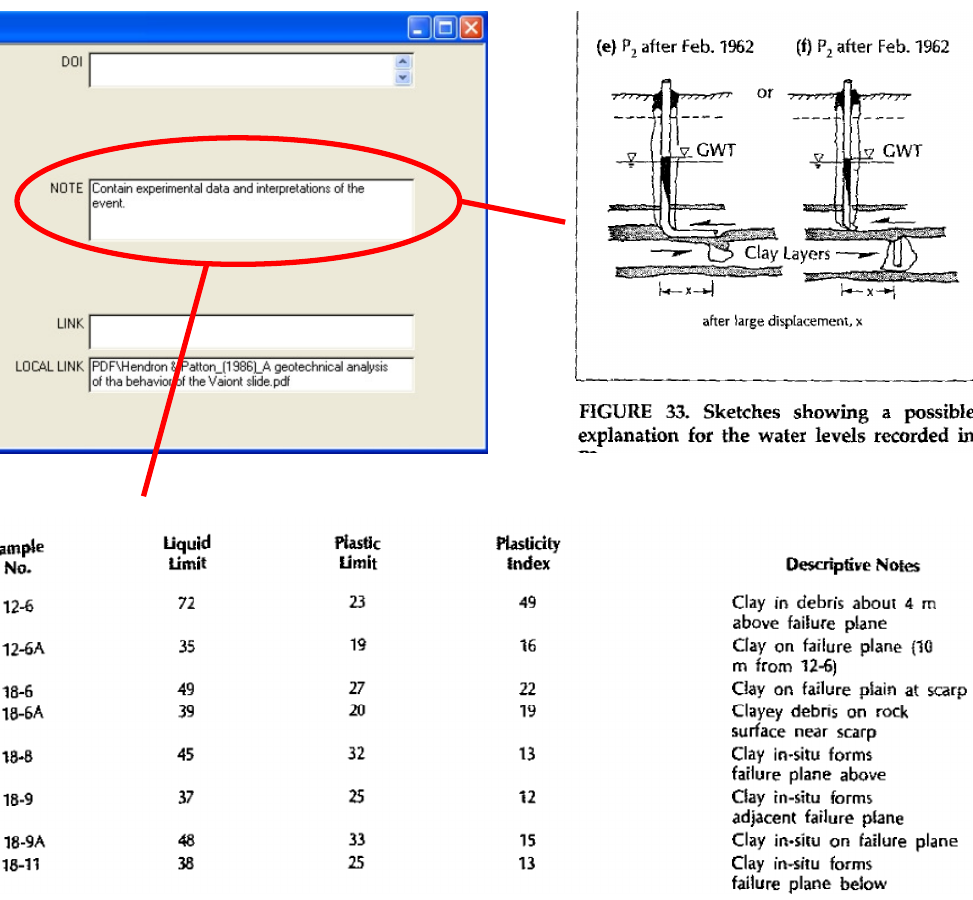
Fig. 4. Example of data and interpretations reported in the field NOTE of the e-bibliography. Sketches from Hendron and Patton (1986).